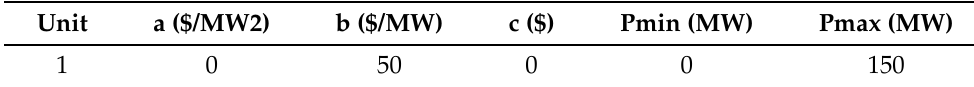
Table A1. Electrical Energy Generator unit data for Case Study 1.